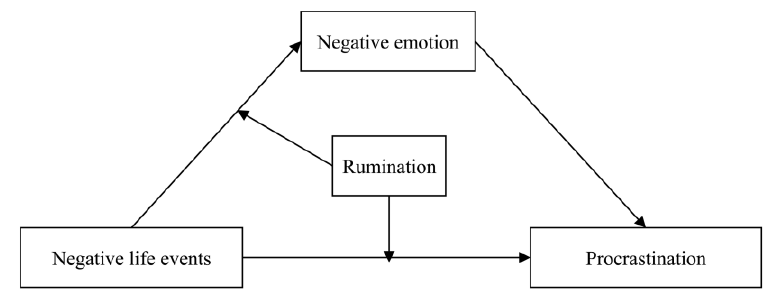
Figure 1. Conceptual model.